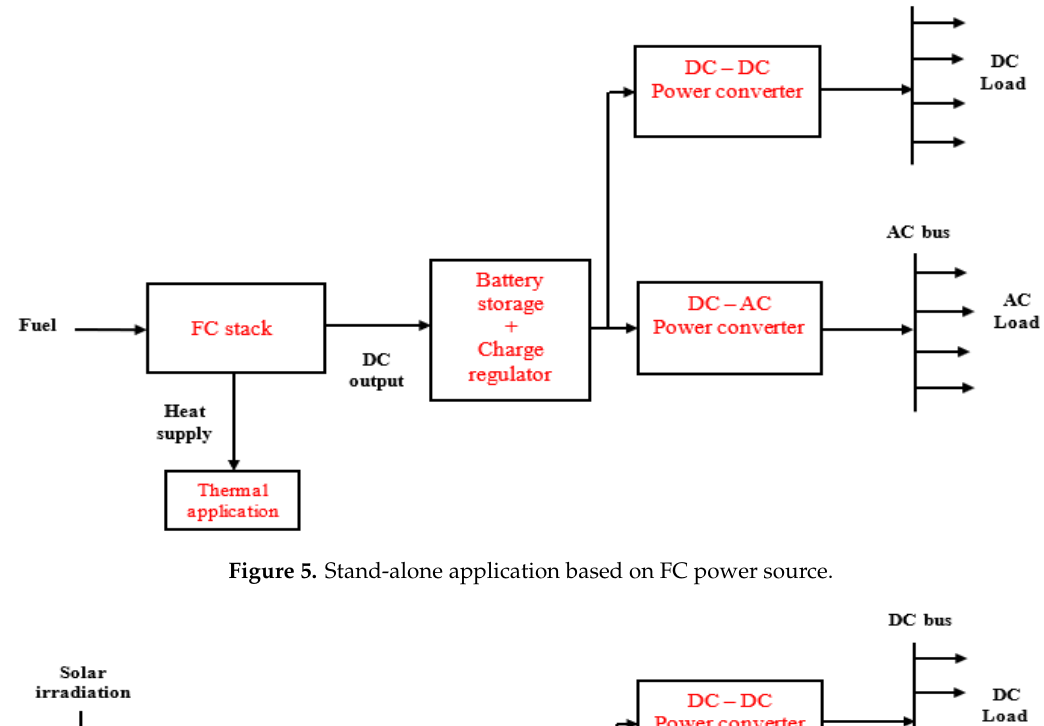
Figure 5. Stand-alone application based on FC power source.